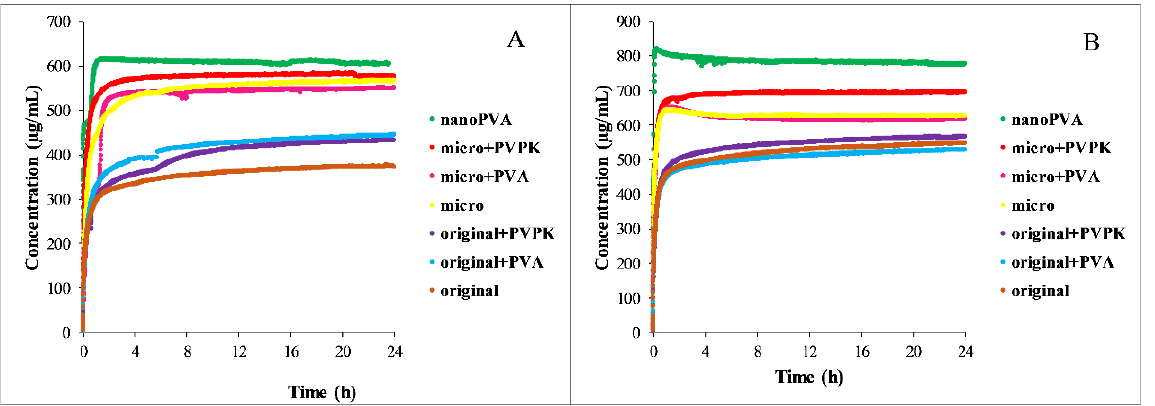
Figure 5. Dissolution profile of furosemide in FeSSIF blank ( A ) and FeSSIF full ( B ) medium.